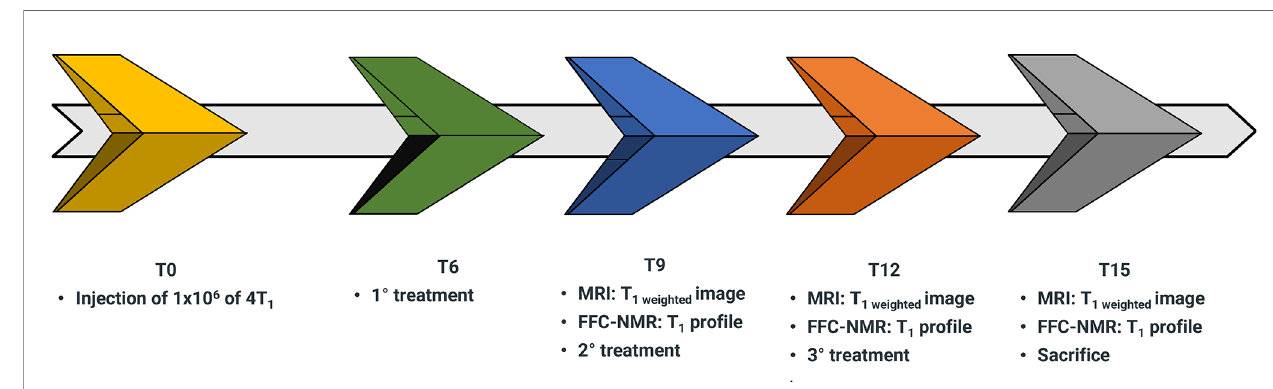
FIGURE 3 | Schematic representation of the work fl ow for the assessment of doxorubicin treatment in 4T1 tumor animal models over a time course of 15 days